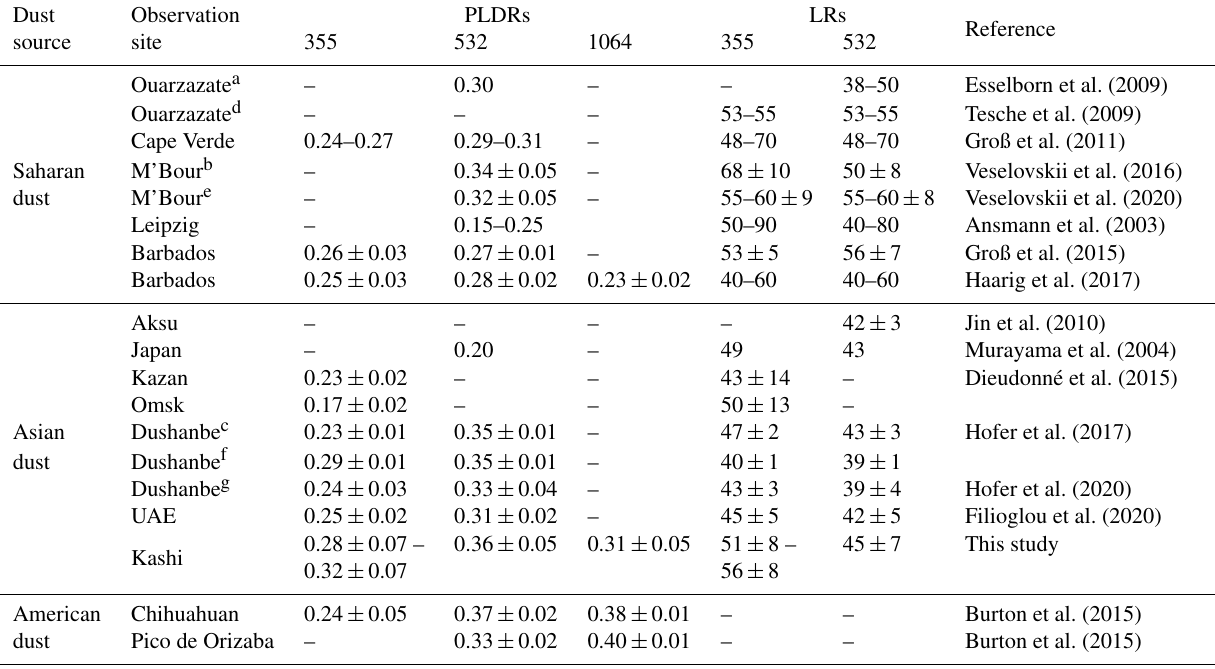
Table 3. A review of dust lidar ratios and particle linear depolarization ratios in literatures. The values of lidar ratios and PLDRs, as well as their errors, are based on the results in the references. Error estimates are not provided if their are not available in the original